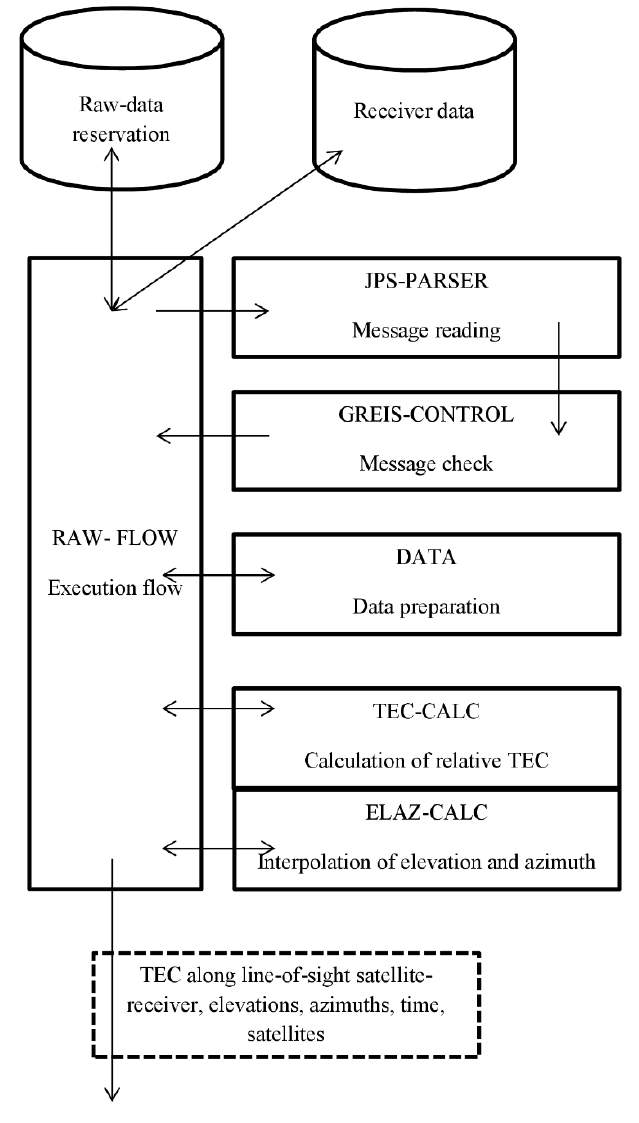
Figure 5. Data diagram for GNSS receiver raw-data processing module.